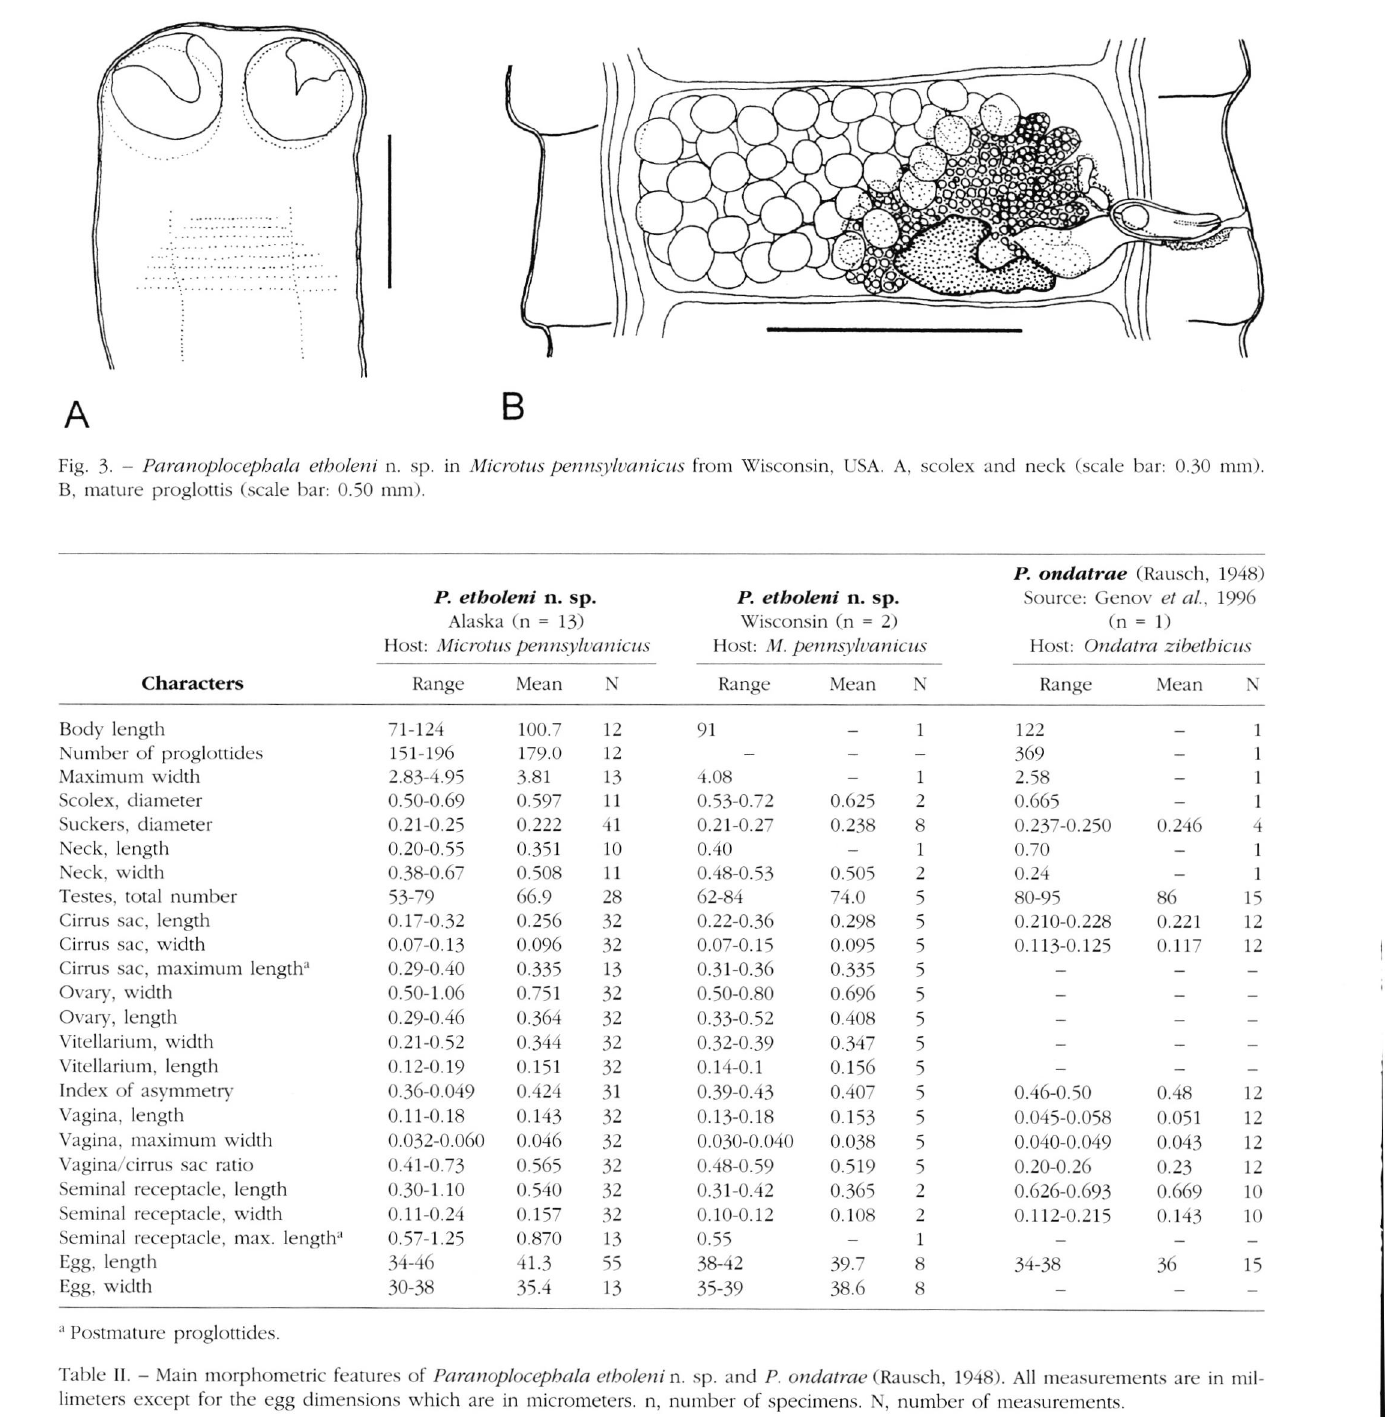
Fig. 3. - Paranoplocephala etboleni n. sp. in Microtus pennsylvanicus from Wisconsin, USA. A, scolex and neck (scale bar: 0.30 mm). B, mature proglottis (scale bar: 0.50